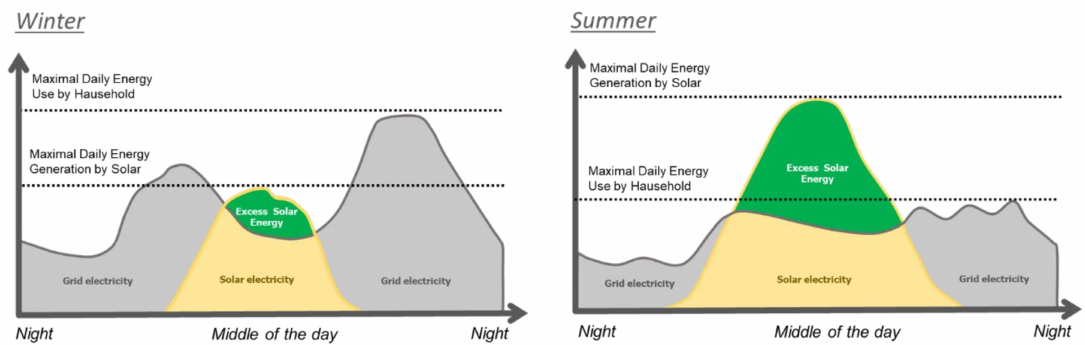
Figure 2. Characteristic correlations in electricity production from photovoltaic panels in the summer and winter months (based on